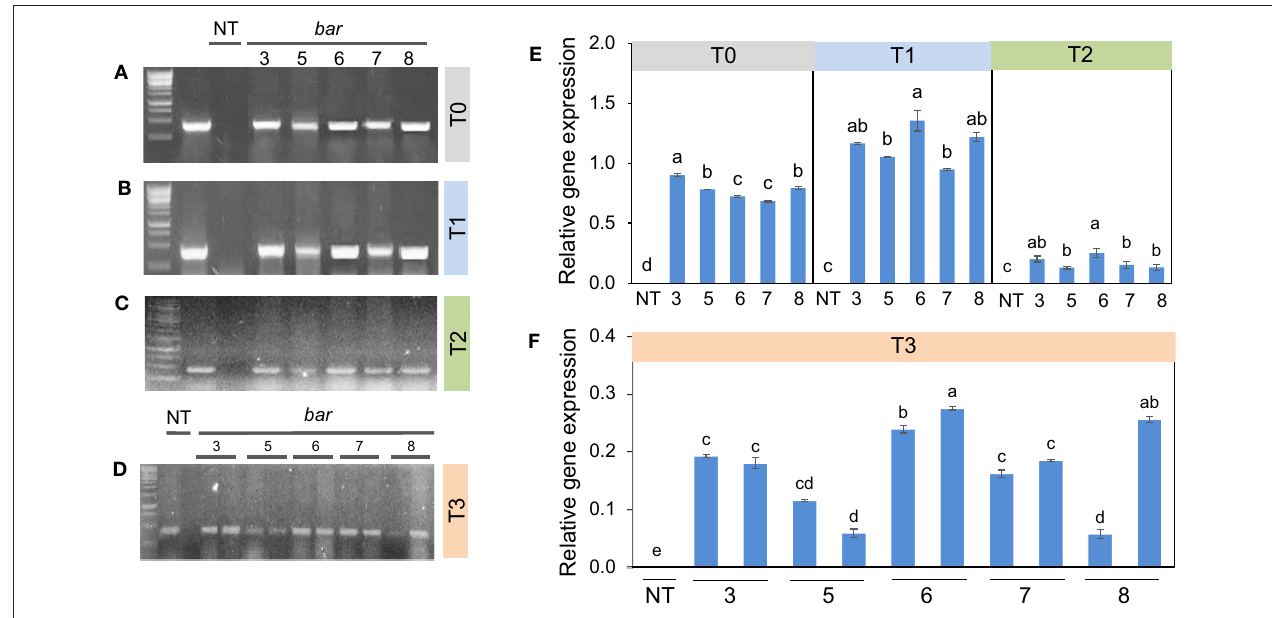
FIGURE 3 | Bar gene expression in transgenic plants from T0 to T3 generations. Among these 3, 5, 6, 7, 8 are transgenic lines and non-transgenic plants (NT). Bar gene expression of five plants (A–C) , left to the right border, in which lane 1 (marker 1kb), lane 2 (plasmid contained pB2WG7 vector), lane 3 negative plant (VX93 non-transgenic, NT), lanes 4 to 8 T0 and T2 generation, respectively. (D) left to right border, it showed 10 plants in the T3 generation (from lanes 4 to 13), therein lane 1 is maker 1kb, lane 2 is plasmid contained pB2WG7 vector, lane 3 is a negative plant (VX93 non-transgenic), and lanes 4 to 13 are transgenic plants. Relative gene expression of T0 to T2 (E) , and T3 (F) for each plant consistently.